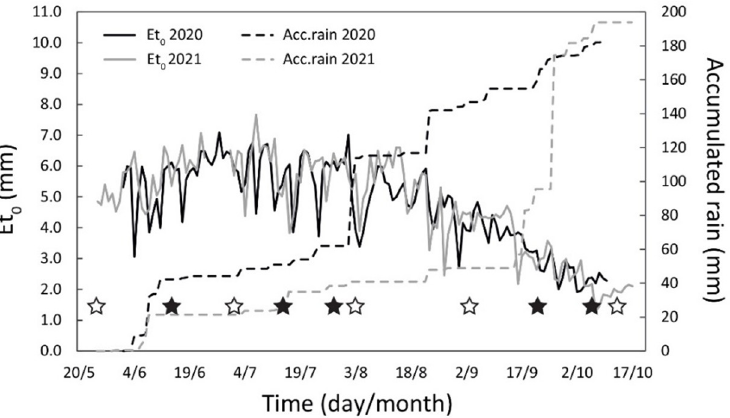
Figure 2. Seasonal patterns of external reference evapotranspiration and accumulated rainfall from the end of May until mid-October for 2020 and 2021 seasons. Midday physiological measurements dates are represented by black (2020) and white (2021) stars.